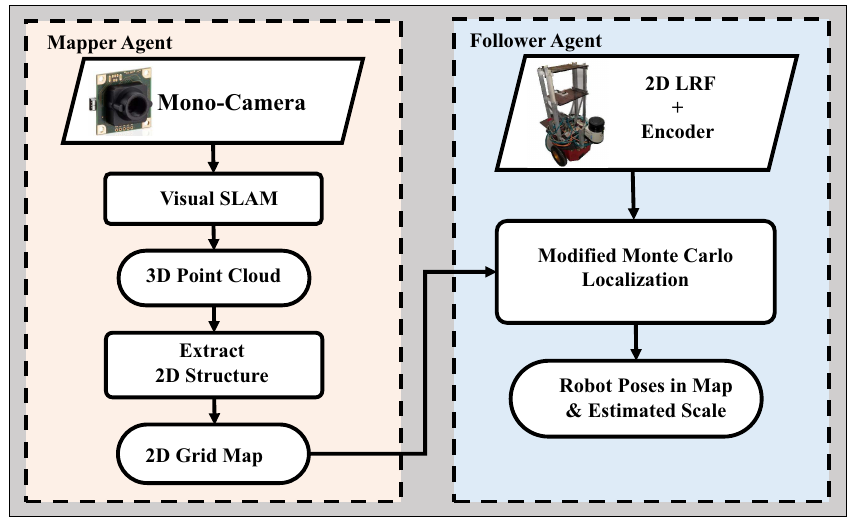
Figure 1. An overview of the proposed system, which is mainly composed of a “mapper” and a “follower”